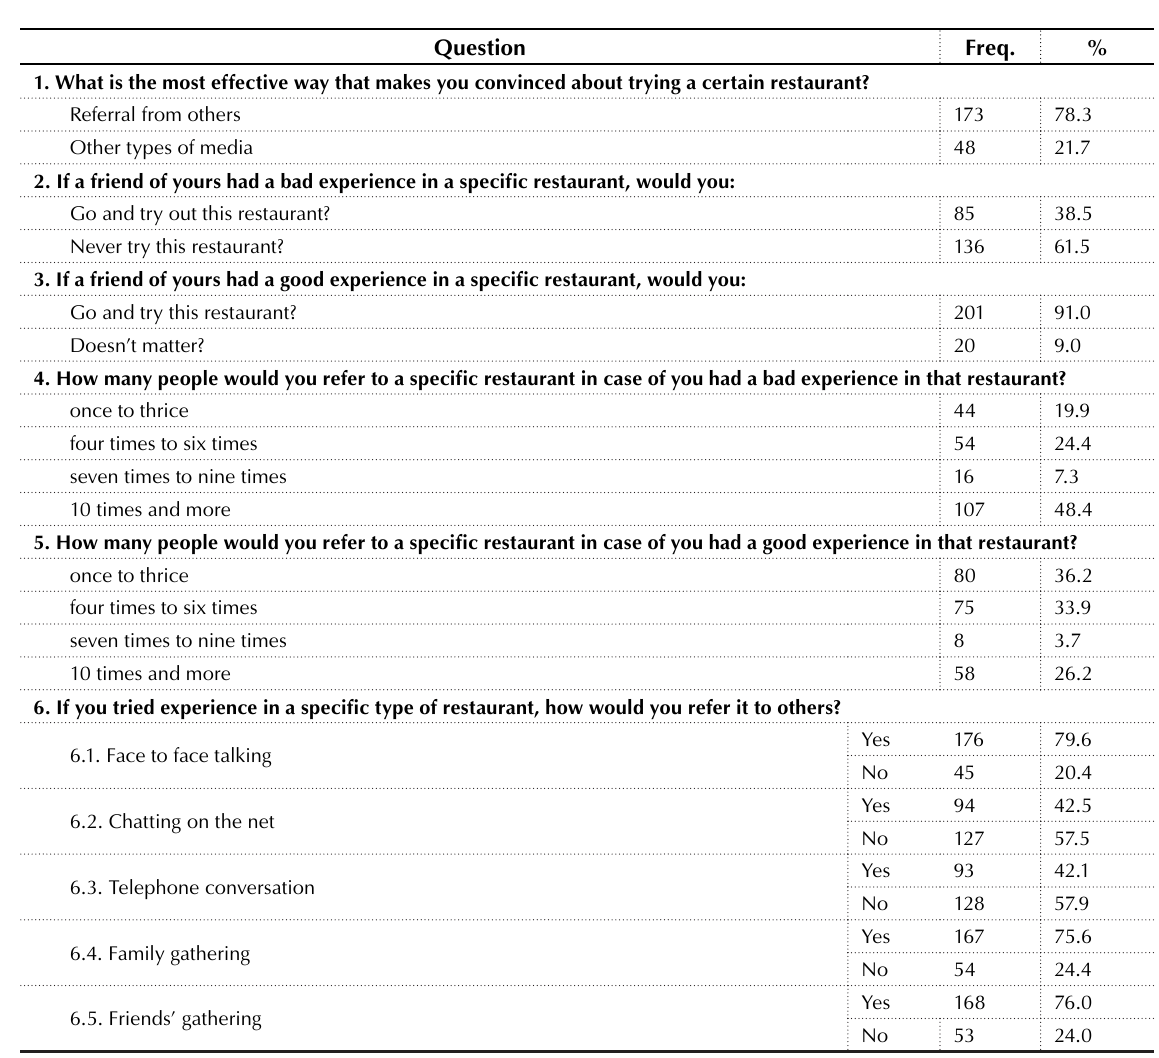
Table 1. Basic WOM-related behaviors and referral